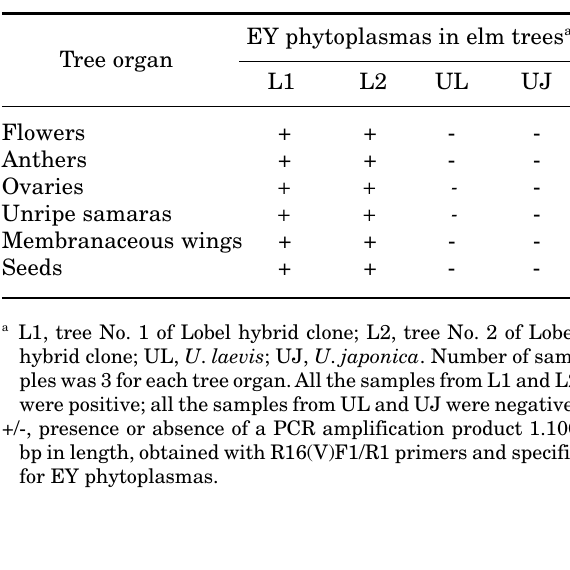
Table 2. Presence of Elm Yellows (EY) phytoplasmas de- tected by PCR experiments on different organs of Ul- mus laevis , U . japonica , and the two hybrid elm Lobel trees.